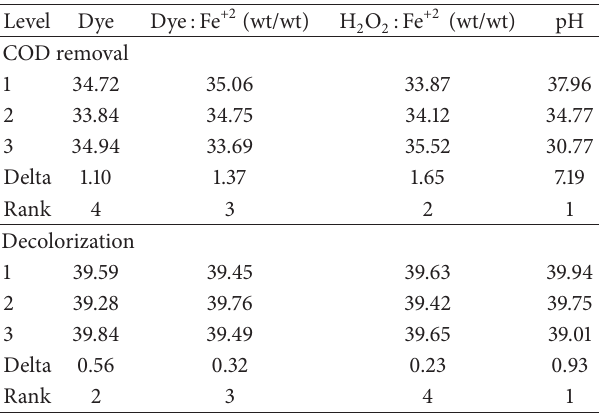
Table 8: Response table for signal to noise ( 𝑆 / 𝑁 )